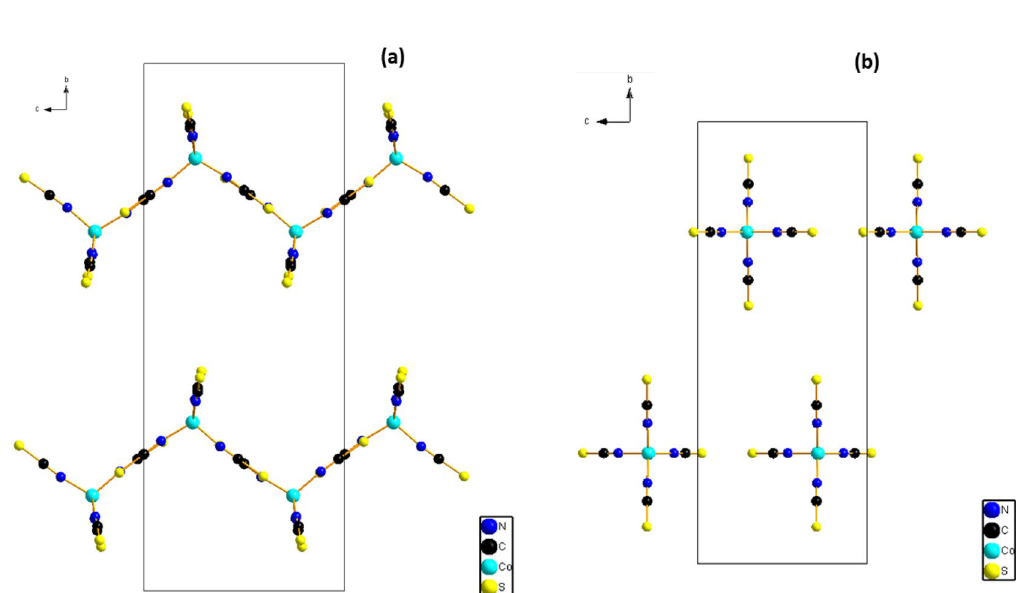
Figure 3. Projection of the anionic part along the a -axis of the structure of ( a ) {[Co(SCN) 4 ] (C 8 H 12 N) 3 }·Cl and ( b )